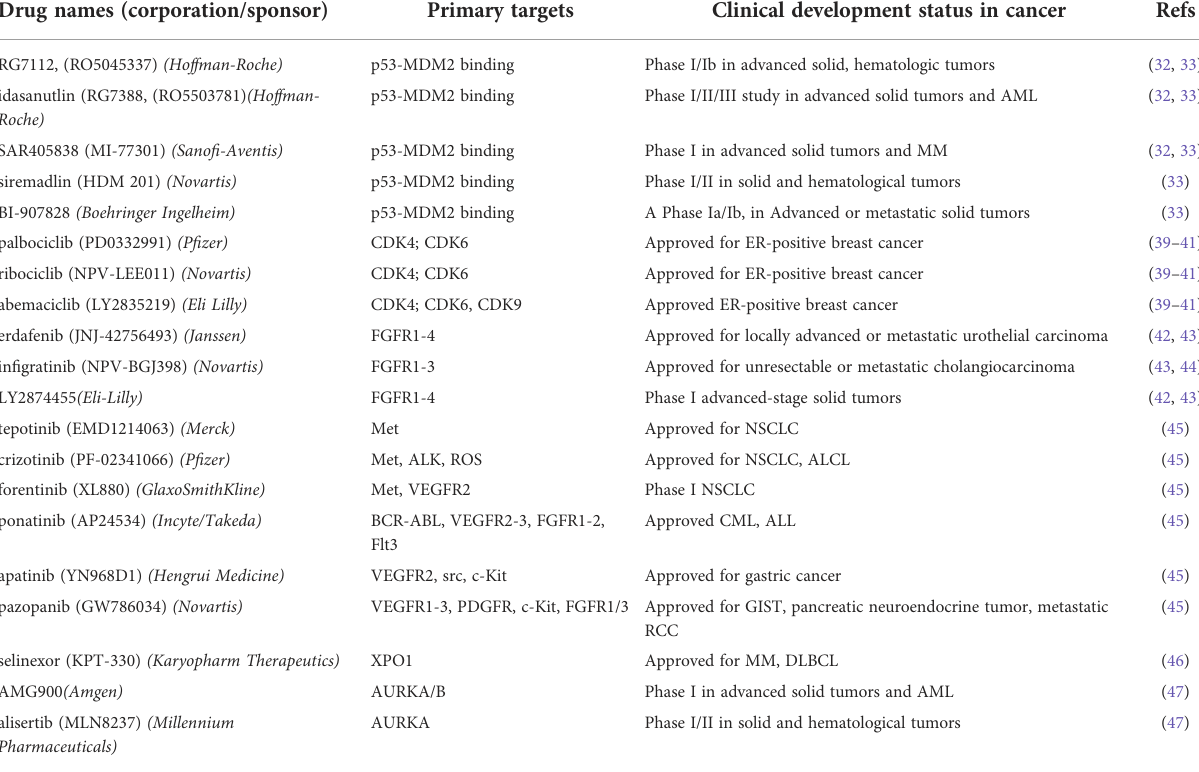
TABLE 1 Investigational drugs in well differentiated and dedifferentiated